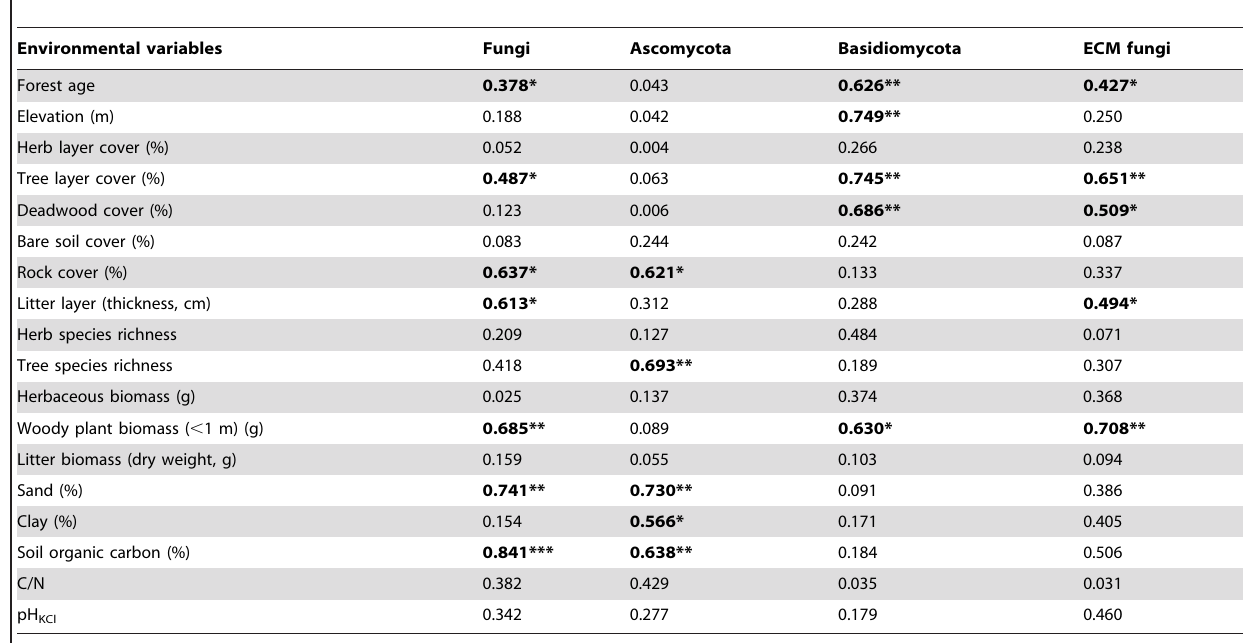
Table 2. Goodness of fit statistics or squared coefficients of environmental variables fitted to the Nonmetric Multi-dimensional Scaling (NMDS) ordination space of fungal, Ascomycota, Basidiomycota, and ECM fungal communities.